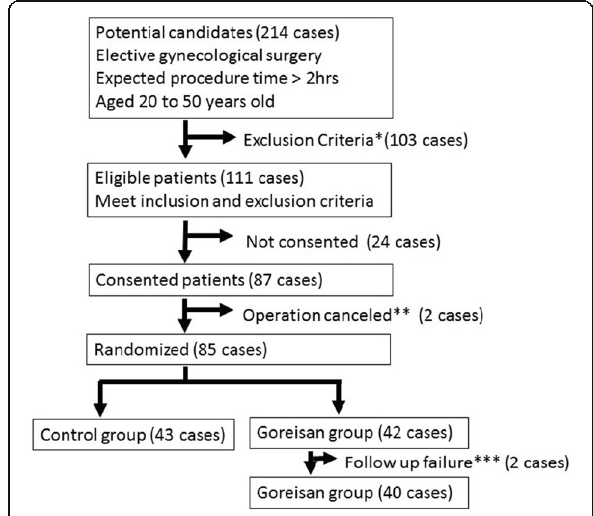
Fig. 1 Study flowchart. (One asterisk) Exclusion Criteria: Cardiac disease, liver dysfunction, renal dysfunction, ASA-PS > 3, pregnant, lactating, or current prescription for any Kampo medicine, steroids, immunosuppressive drugs, or anticancer drugs. (Two asterisks) Two cases were removed due to developing a fever or unknown origin on the day of surgery. (Three asterisks) Two cases dropped out due to a technical failure and the inability to obtain follow-up data